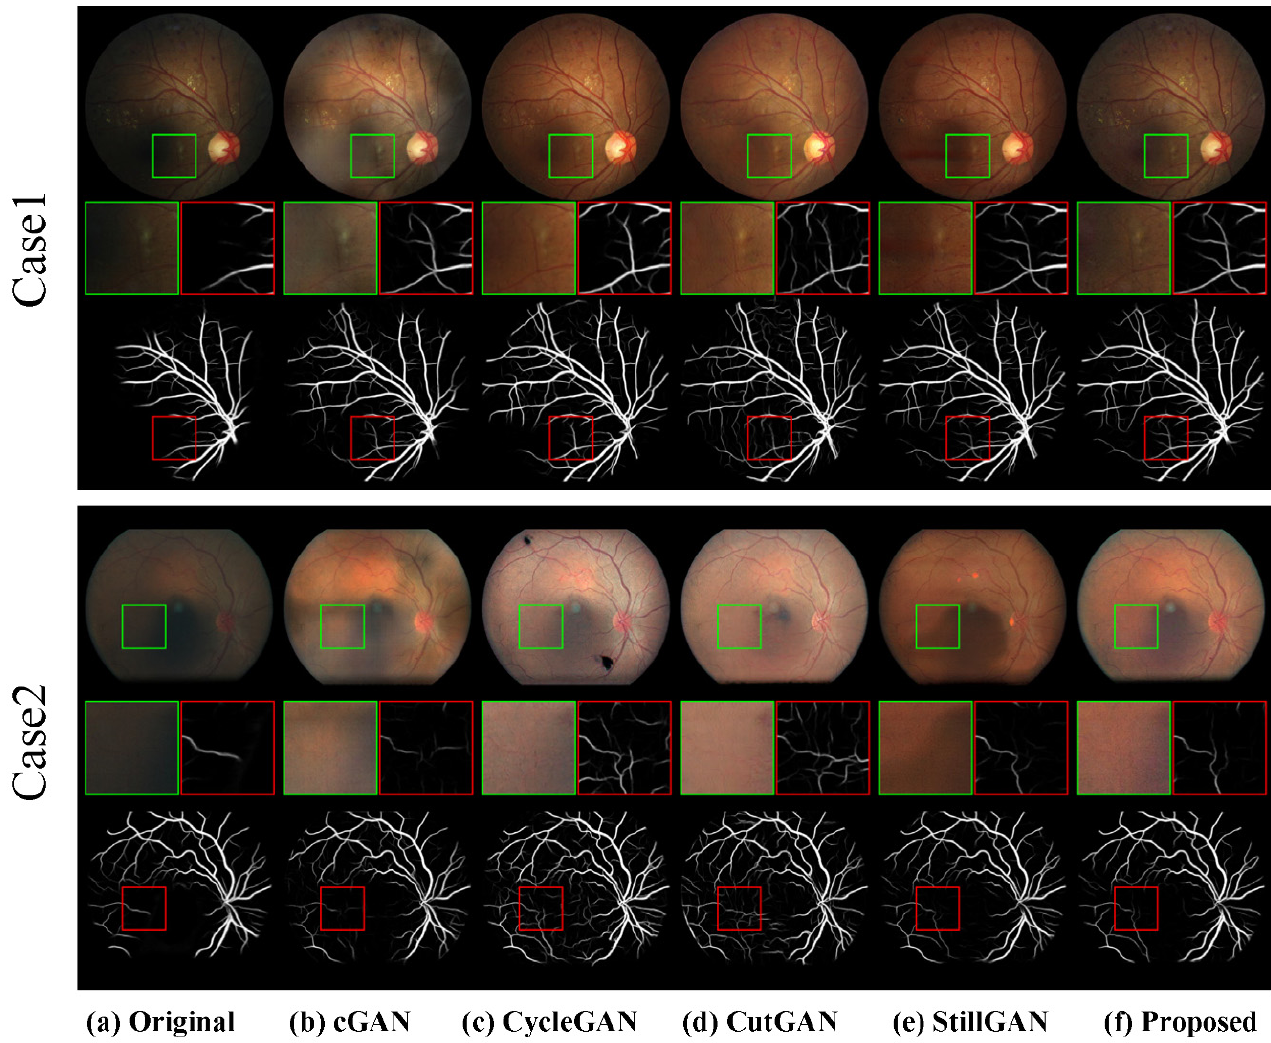
Figure 2. Visual comparisons on the vessel segmentation task. In each case, the first row contains color fundus images enhanced by different methods, and the last row contains corresponding segmentation results. In the middle row, the green box is cropped from color fundus while the red box is cropped from the corresponding area of the segmentation results.